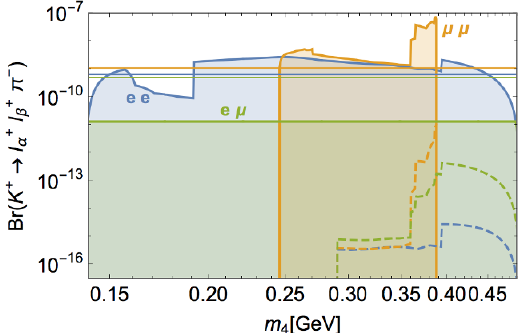
Figure 15 . Branching ratios of LNV decay modes of K mesons, K + ! ‘ + tion of the (mostly sterile) heavy neutrino mass, m 4 . Pale blue, yellow and green curves (surfaces) respectively denote the maximal (allowed) values of the BR( K + ! ‘ + ( ‘ + ‘ + ) = ( e + e + ; (cid:22) + (cid:22) + ; e + (cid:22) + ); coloured dashed curves denote the corresponding maximal values (cid:11) (cid:12) of the BRs once c(cid:28) 4 (cid:20) 10 m is imposed. The coloured horizontal lines correspond to the present experimental bounds (cf. table